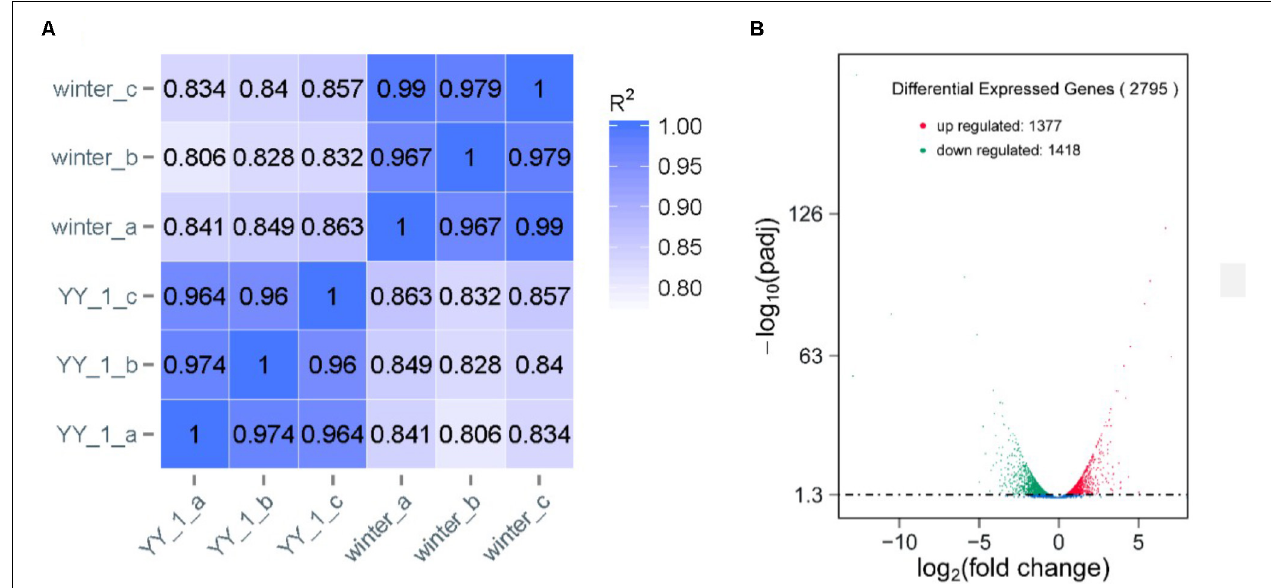
FIGURE 2 | Transcriptomic profiles of the M. purpureus YY-1 and winter strains during pigment production. (A) Correlation comparison between biological replicates. The Spearman correlation coefficients ( R 2 ) were calculated. (B) Differential gene expression. In the statistical analysis of differential gene expression, the transcriptomes derived from the YY-1 strain were used as